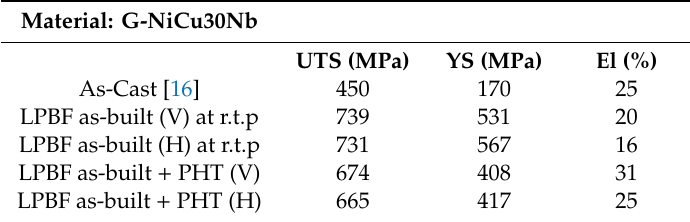
Figure 10. Tensile properties of as-built specimens (ys: 140 µm, Vs: 850 mm/s) shown in both horizontal and vertical orientations by stress–strain diagram and bar chart highlighting anisotropy in different building orientations. Table 4. Summary of compared tensile properties.